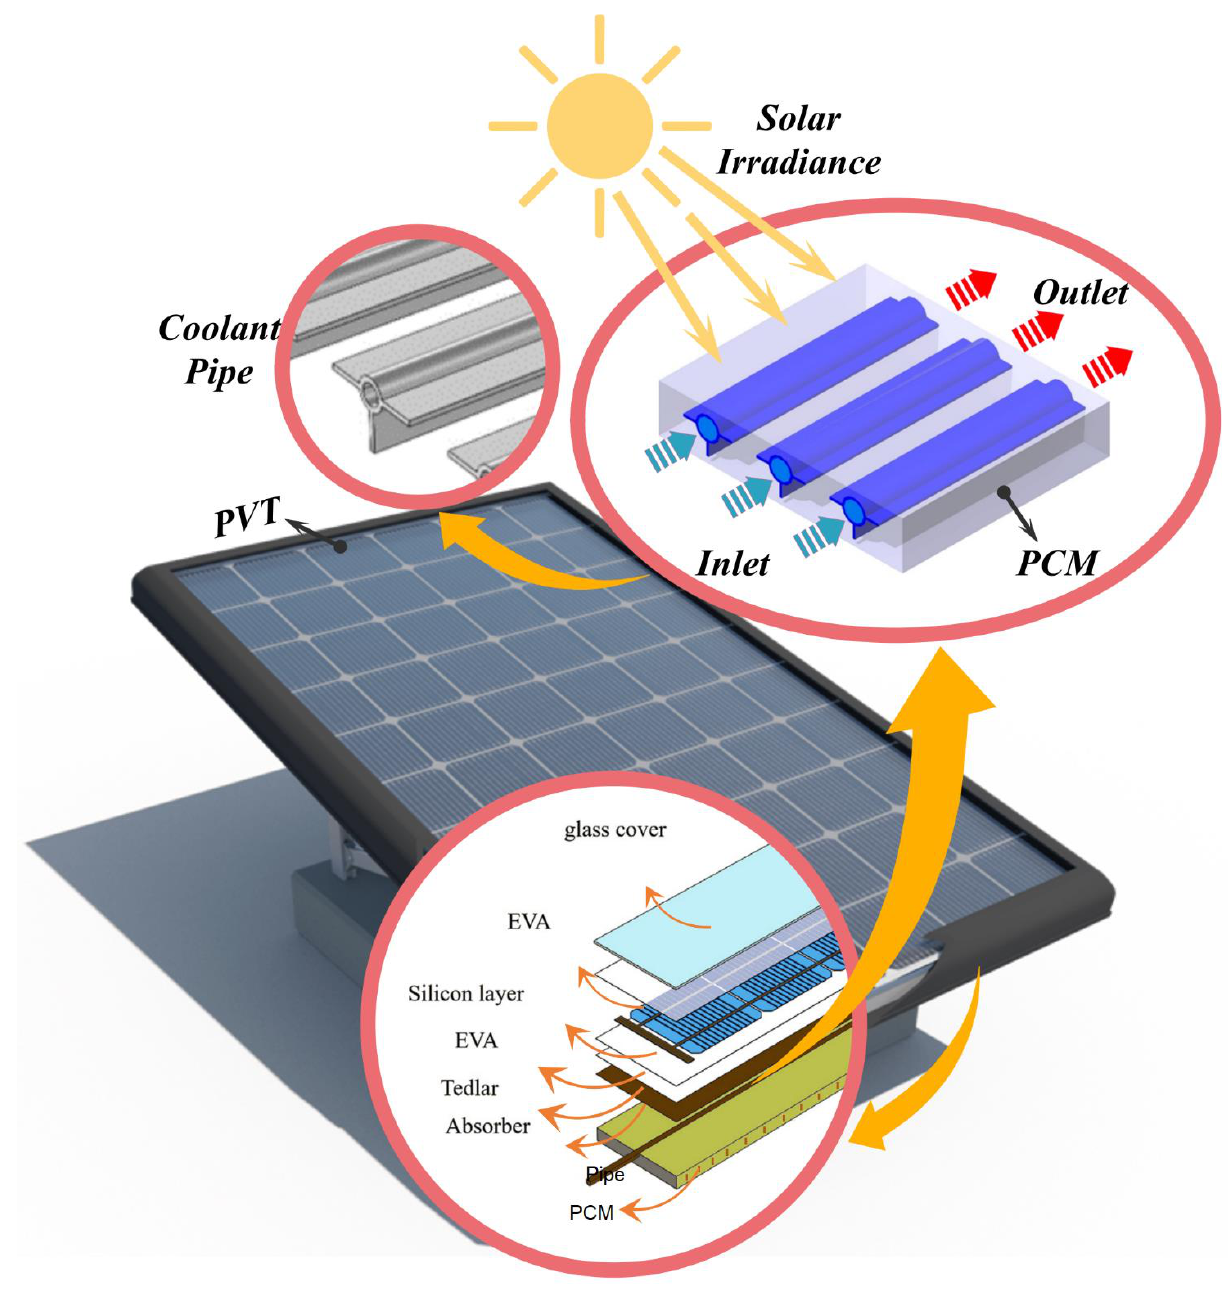
Figure 1. Schematic of the system with PCM and NFD flow pipe.